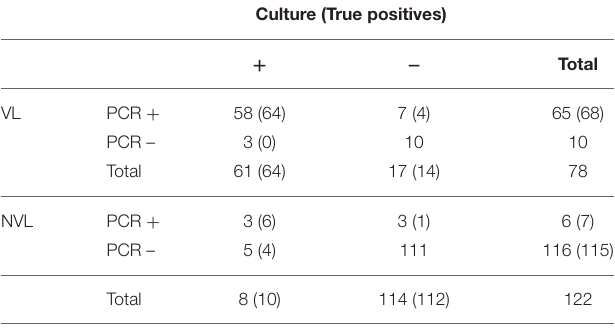
TABLE 2 | Comparison of results obtained by analyzing 200 randomly selected veterinary samples by microbiological culture and Real-Time PCR, according to the presence or absence of anatomic